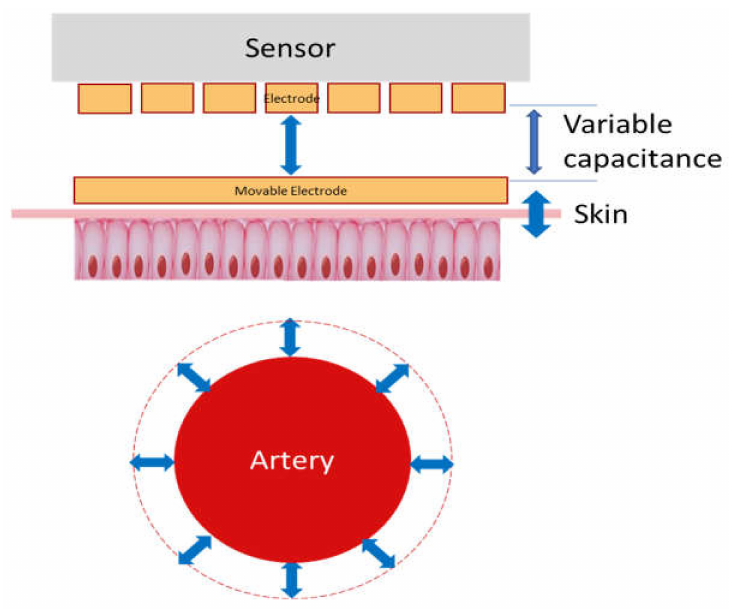
Figure 2. Schematic of operating principle of PyrAmes’ capacitive sensor technology.